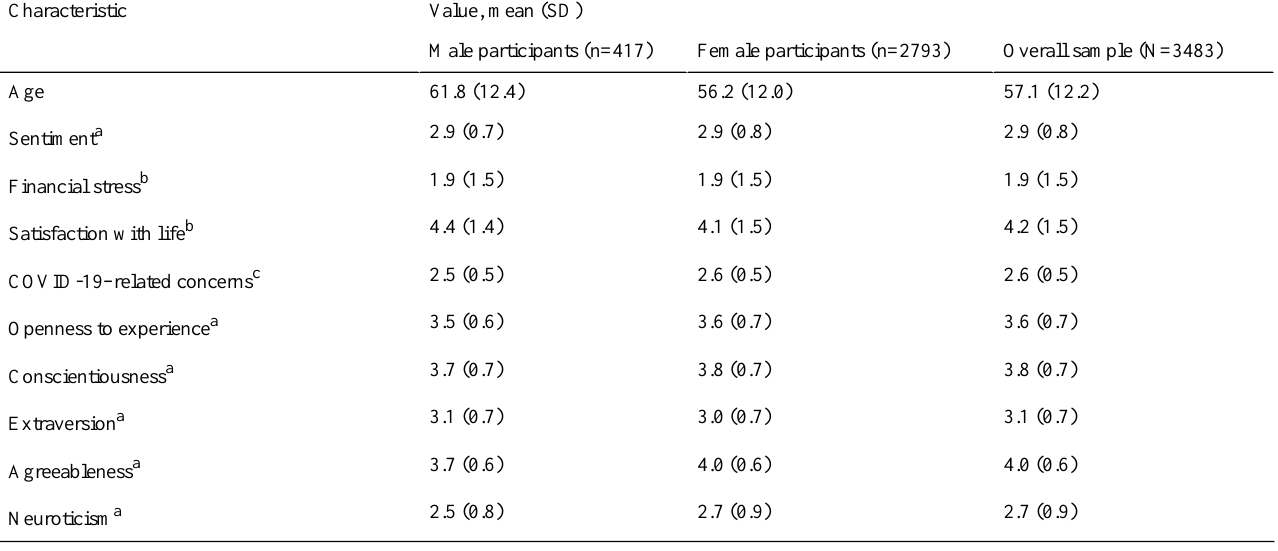
Table 1. Participant characteristics among a sample of Australian adults in a cross-sectional study investigating the psychosocial impacts of COVID-19 in May 2020 (N=3483). For all variables, a higher score indicates a higher level of that variable. Value, mean